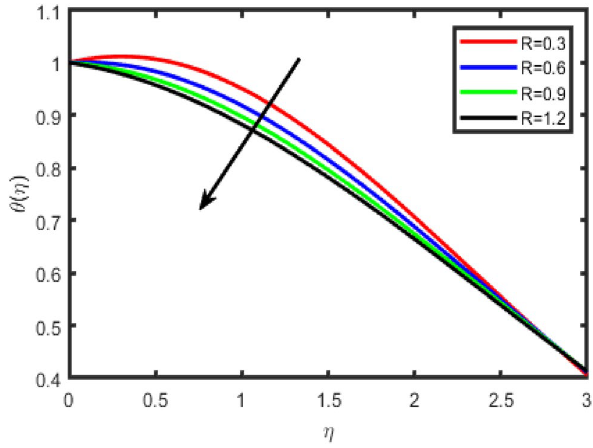
Figure 16. Effect of radiation parameter (R) on temperature θ(η).